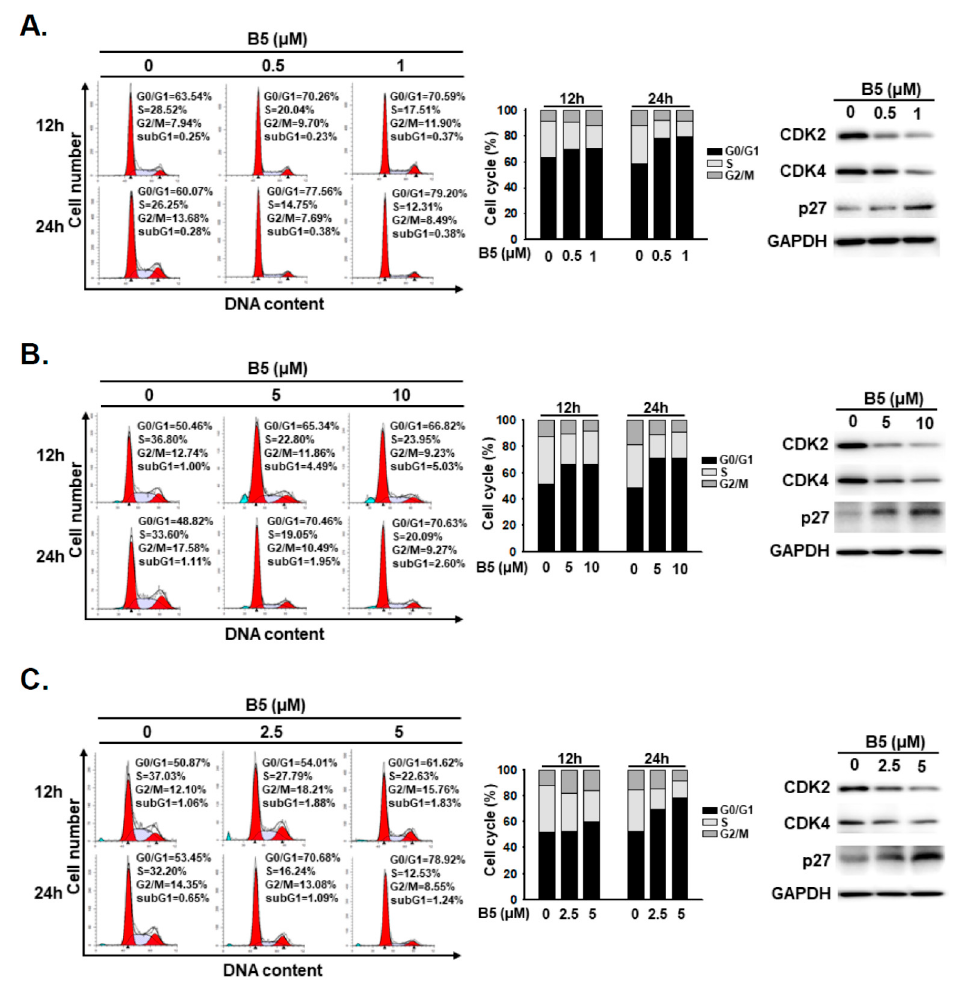
Figure 4. 9- O -farnesylberberrubine bromide induces cell-cycle arrest in NSCLC cells. ( A ) A549, ( B ) H23, and ( C ) H1435 cells were incubated with a control medium or that containing B5 for 12 h and 24 h. The cell cycle was studied using flow cytometry. The expression of CDK2, CDK4, and p27 in the total cell lysate after the 24-h treatment was examined using western blot analysis. GAPDH was used as a loading control. Three independent experiments were performed, and a representative experiment was shown.